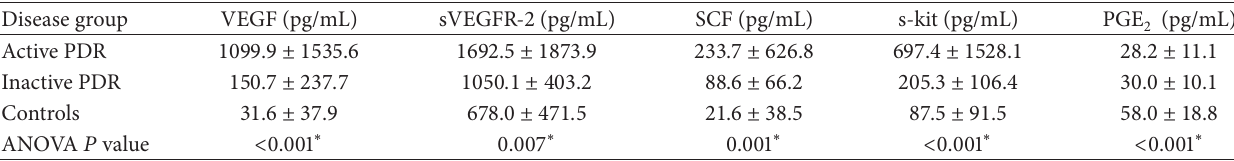
Table 2: Comparisons of mean angiogenic and vasculogenic factor levels in proliferative diabetic retinopathy (PDR) patients with or without active neovascularization.